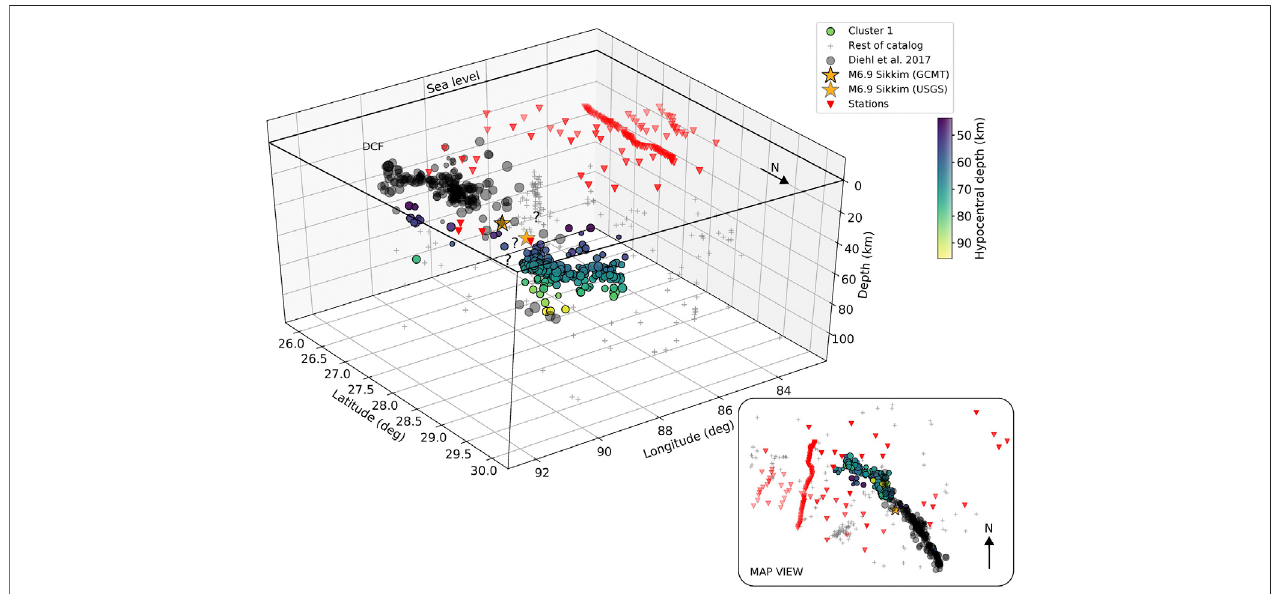
FIGURE10| ThreedimensionalviewofseismicitynearDhubri-Chungthangfaultzone(DCFZ)andCluster1.Hypocenterlocationsdeterminedinthisstudy,located inCluster1,arecoloredaccordingtotheirhypocentraldepths(seecolorscale)andtherestoftheeventsinthecatalogaredepictedwithgraycrosses.Blackcirclesshow the seismicity located by Diehl et al. (2017) in the vicinity of DCFZ. Stars show the M6.9 2011 Sikkim Himalaya earthquake hypocenters provided by the U.S. Geological Survey (USGS) and the Global Centroid Moment Tensor (GCMT). Question marks depict the region where the DCFZ seismicity could be connected to Cluster 1, possibly through the M6.9 event. Inset shows the map view of the seismicity. For a more detailed view of the seismicity see also Supplementary Video S1 .